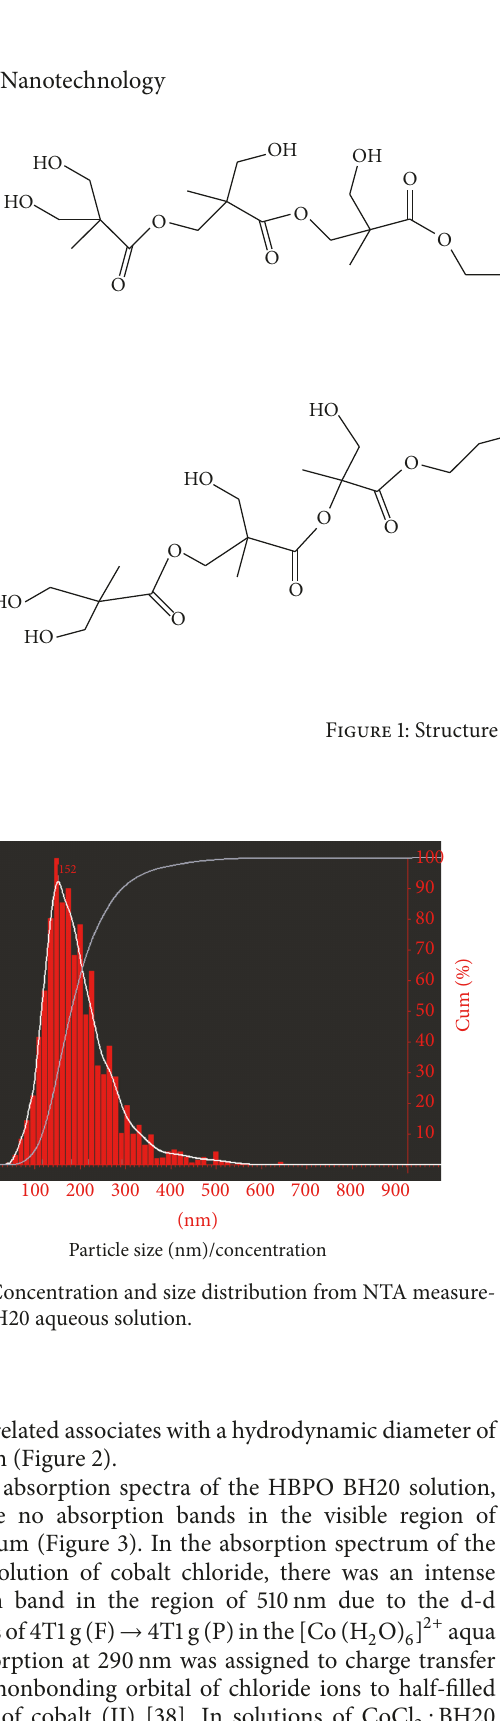
hydroxyl groups of HBPO and the formation of Co 2+ ,